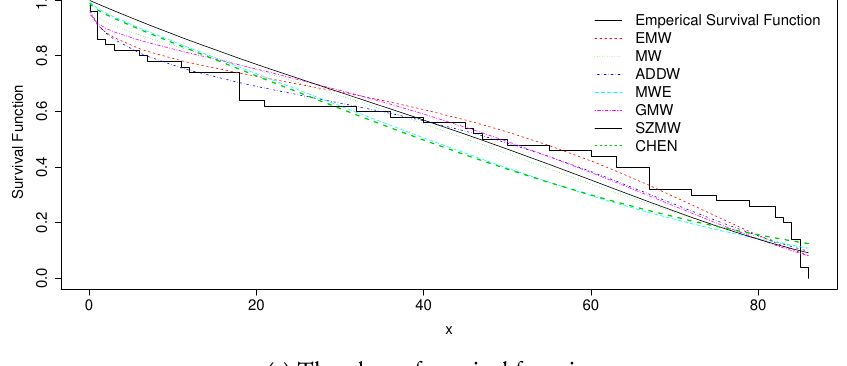
(c) The plots of survival function. Figure 5 – Model fitting plots for